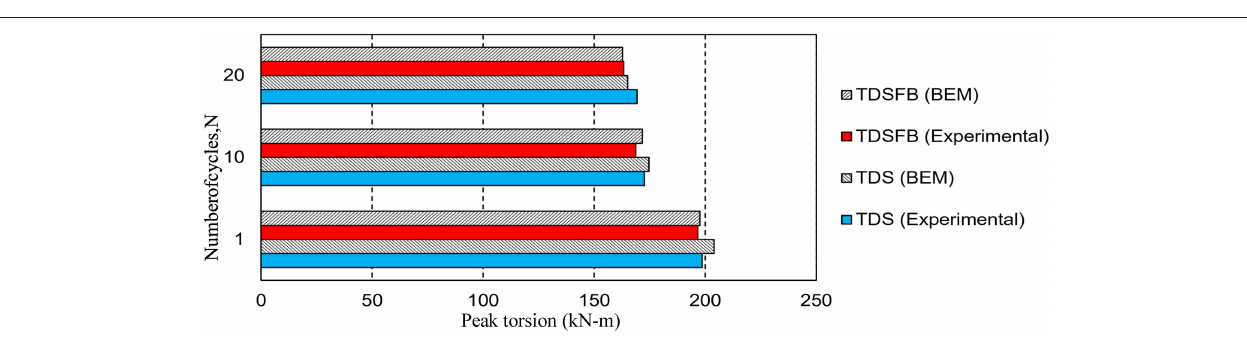
FIGURE 5 | Comparison of the results computed using BEM with field test data of Stuedlein et al.